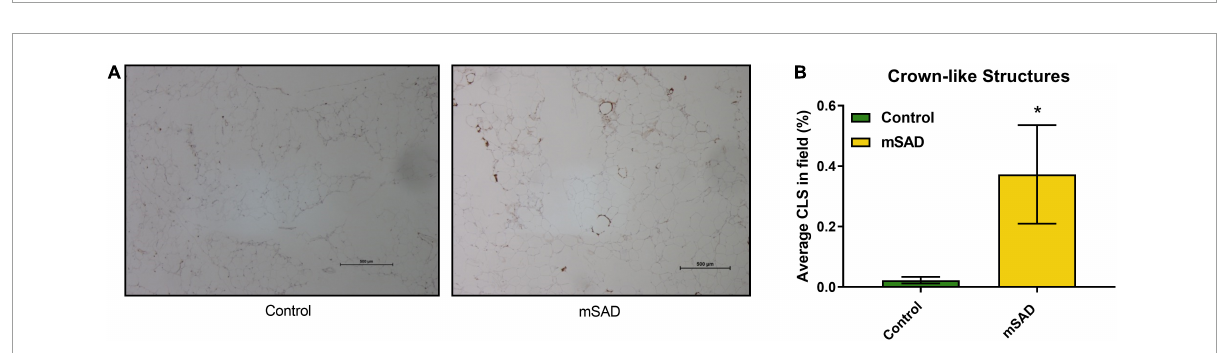
FIGURE6 Effects of diet on gonadal fat pad inflammation. FFPE sections of gonadal fat pads from CON- or mSAD-fed mice were incubated with anti-MAC-2 followed by counter-staining with hematoxylin (A) . Quantification of CLS (B) . Values are represented as the average % area of CLS occupied in the total field of tissue sections. Data were compared using Student’s t -test. * p <